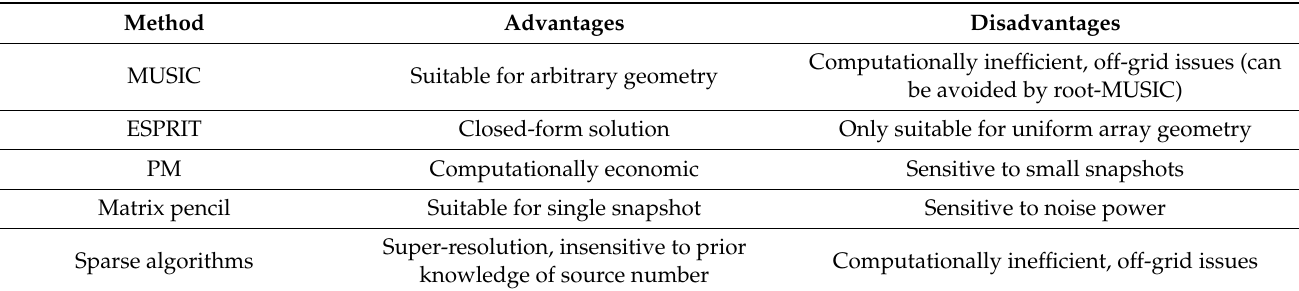
Table 1. Advantages and disadvantages of typical